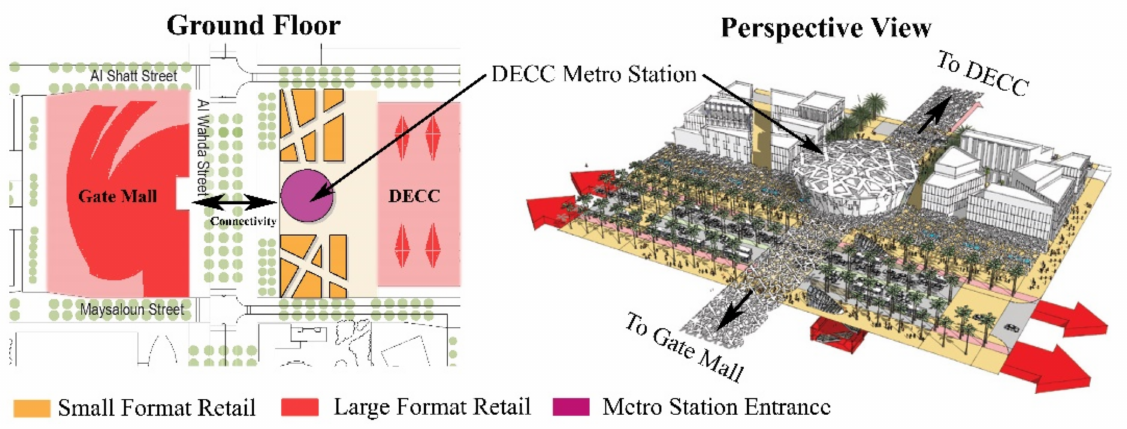
Figure 16. Connectivity Between the DECC Metro Station and its